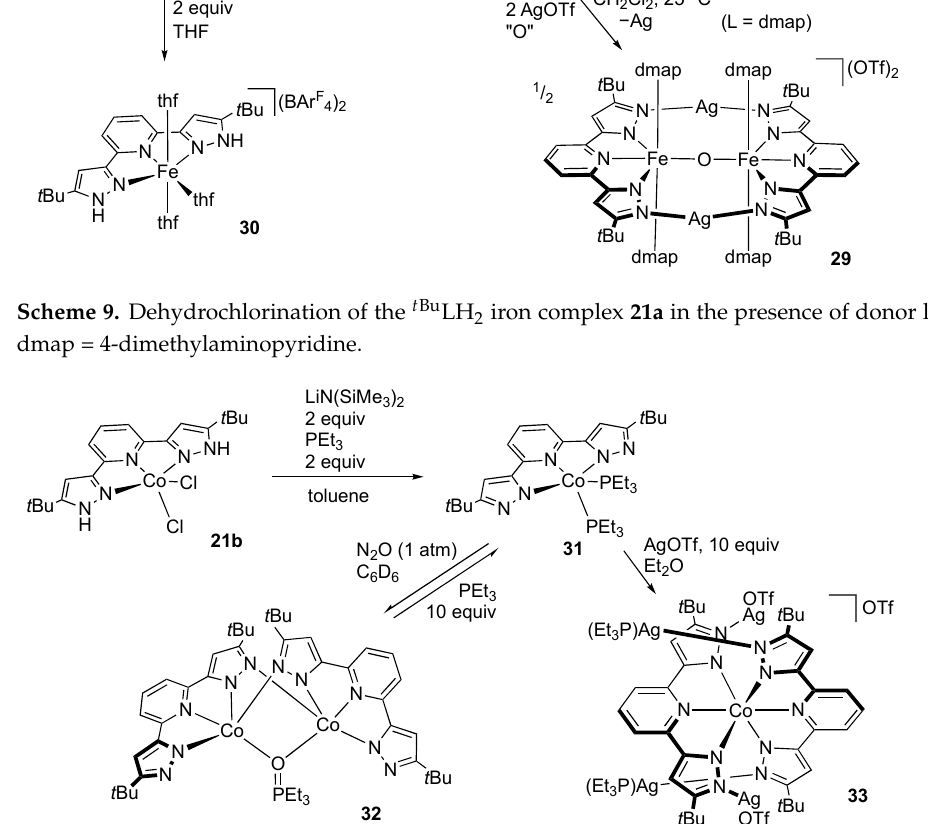
dmap = 4-dimethylaminopyridine.